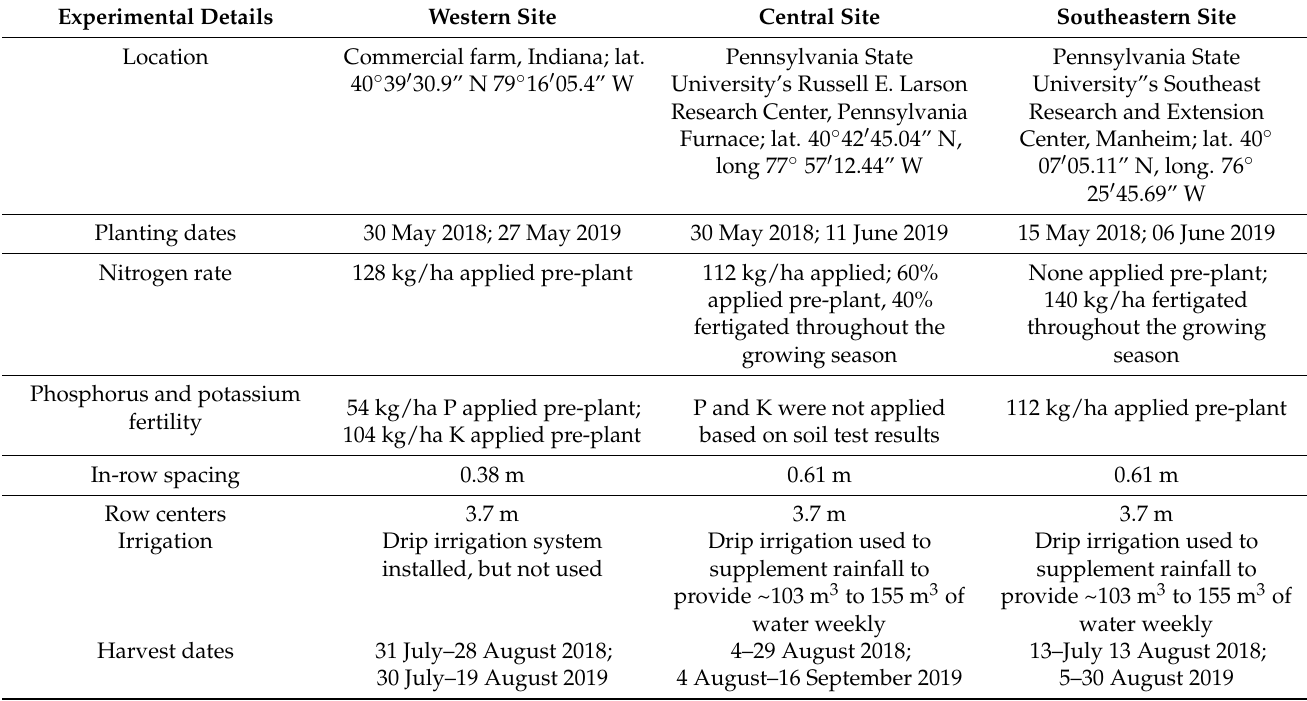
Table 2. Sites, production protocols, and dates used in an evaluation of hybrids and grafted cultivars in Pennsylvania in 2018 and